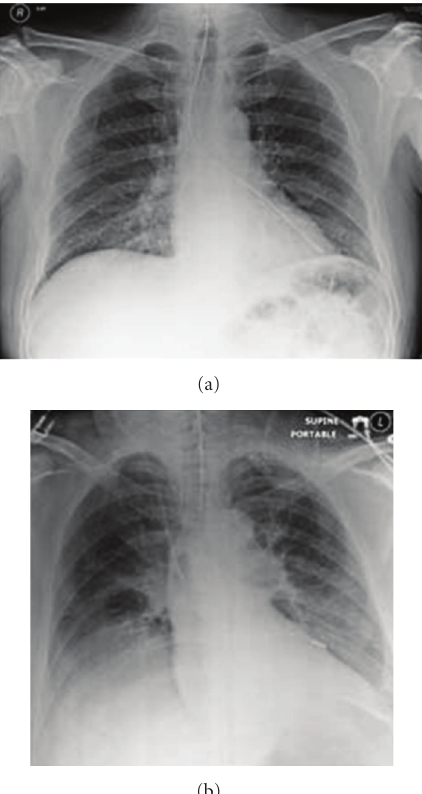
Figure 34: The NGT has entered the left main lower lobe bronchus in two di ff erent patients. (b) shows aspiration pneumonia at both lung bases more pronounced on the